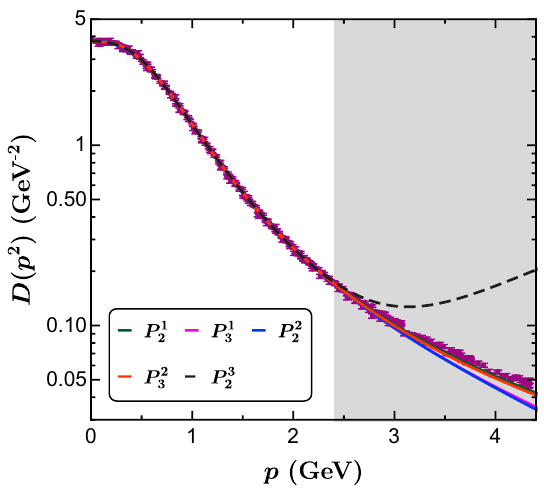
Figure 4 . Comparison of the Padé approximants used to determine the final results and the lattice data. The shaded region — corresponding to p =